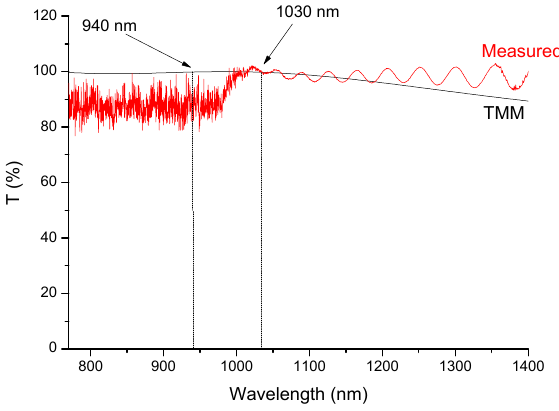
Figure 9. Transmission of an anti-reflective coating (ARC) with 3 layers deposited on 71 SiO 2 -14 AlO 1.5 -15 YbO 1.5 glass film deposited on silicon substrate, compared with TMM simulation.